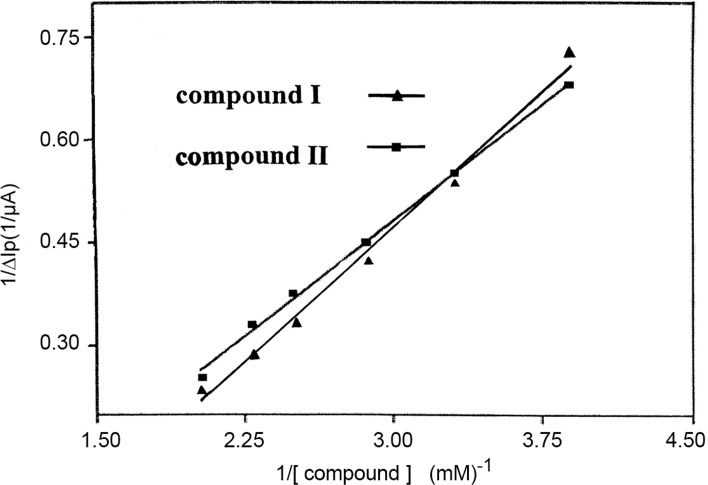
The relationship between 1/ΔIP and 1/C.